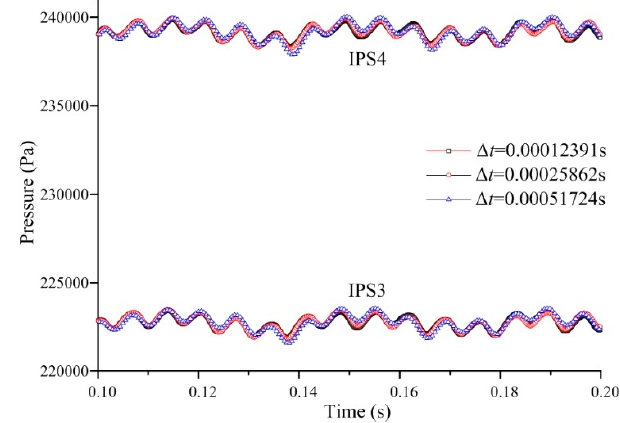
Figure 4. Time histories of pressure fluctuation on IPS3 and